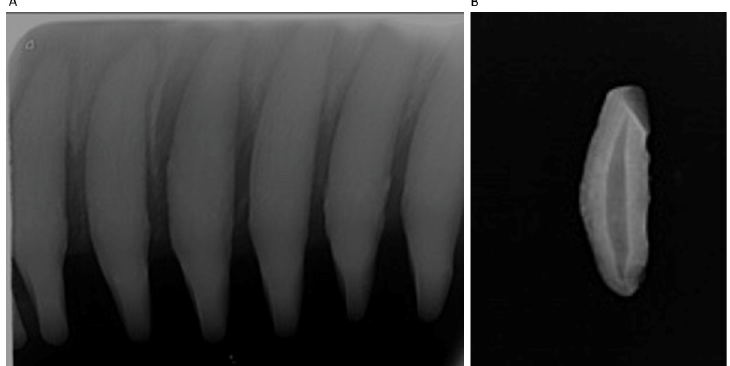
Fig 9. Periapical radiographs of dolphin YN9. Even in cases where the pulp:tooth area ratio is below 0.1 and excluded from age estimation by the model; dental radiographs can help confirm other age estimation techniques. Here, dolphin YN9’s pulp area is very small (A), indicating an older animal. However, radiography shows that the single tooth extracted for GLG-based age estimation is in fact non-vital (B), and therefore likely results in a younger age